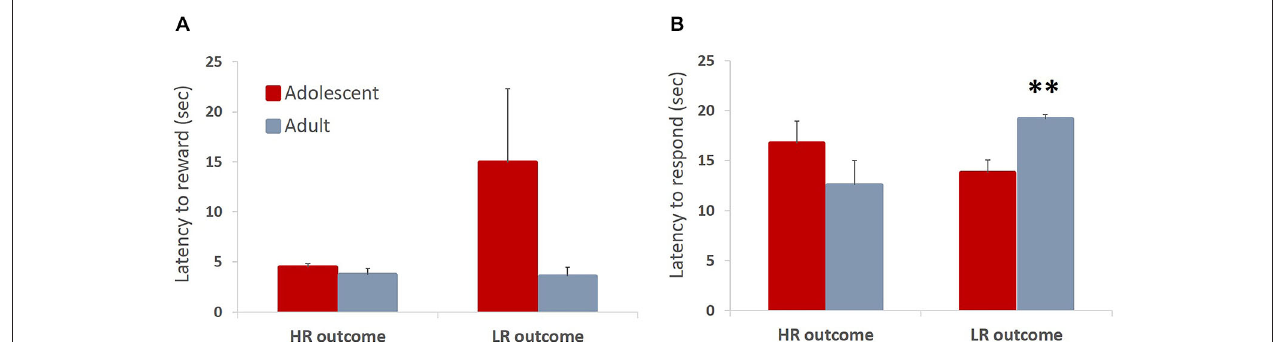
was contingent on their response compared to the “free” LR that was delivered at the end of the trial if the animals failed to respond, although this difference did not reach statistical significance. (B) Adolescent animals were significantly faster to respond on the subsequent trial after receiving the LR compared to adult animals. Whereas there was a tendency for invigoration of response following lesser-than-expected outcome in adolescent animals, adult animals were slowed by such outcomes. ** p <